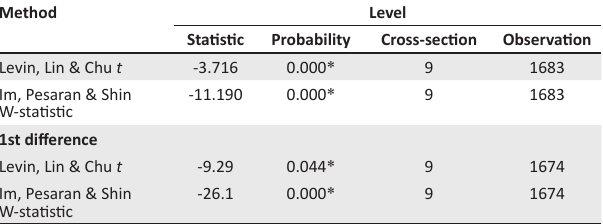
TABLE 4: Panel unit root test: Exchange rate